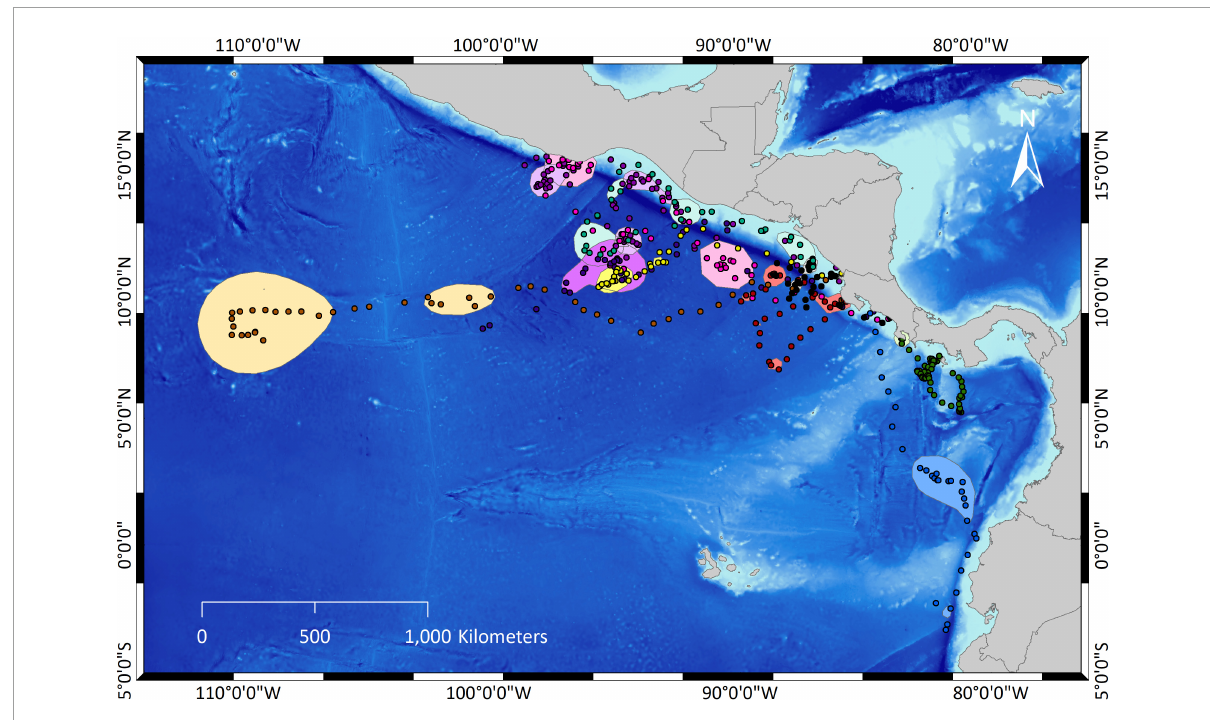
FIGURE5 Comparison of tracks from ten solitary olive ridley turtle females and their respective core areas of high use (PVC 50 ) in the Eastern Tropical Pacific.